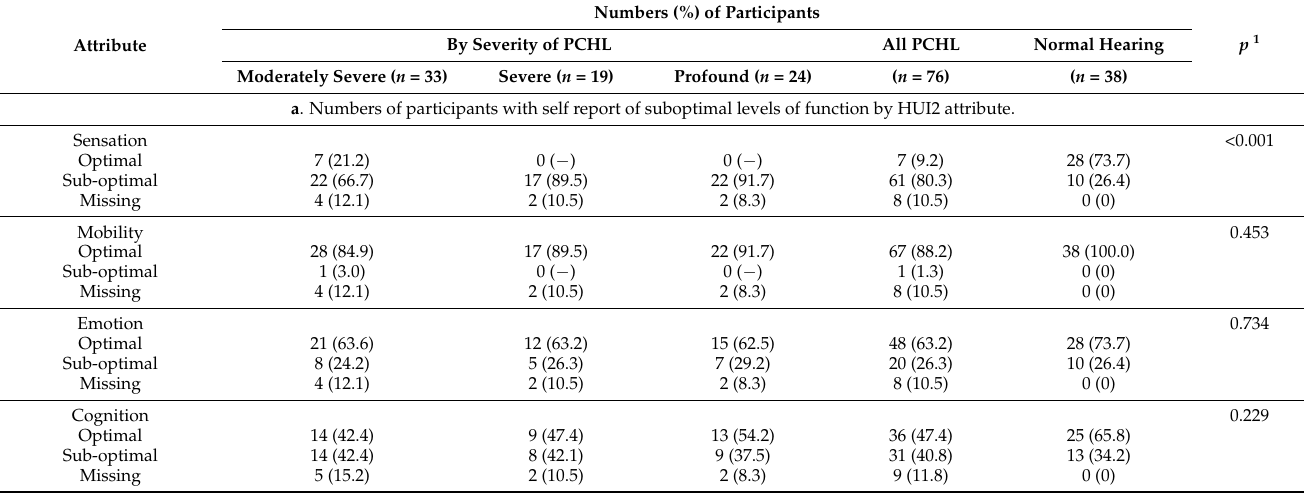
Table A1. Number (%) of participants with suboptimal levels of function by HUI attribute, HUI measure and respondent group.